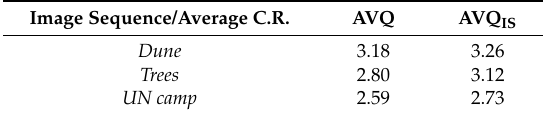
Table 5. Average C.R. (dictionary composed by 4096 entries)–Dataset 2. Image Sequence/Average C.R.